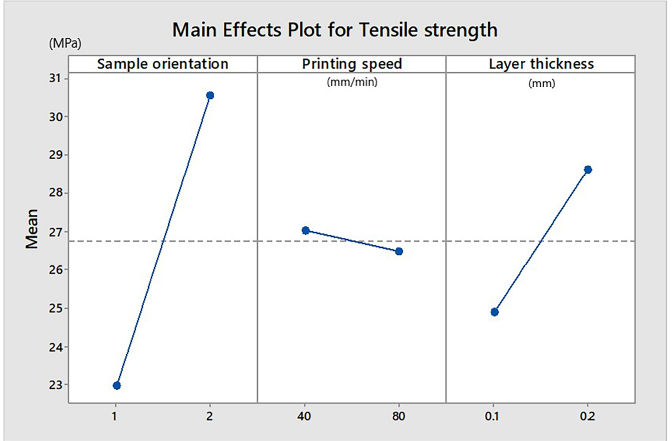
Figure 2. Influence of parameters on tensile strength (Extrudr BDP Flax samples). Sample orientation: 1—plan and 2—on edge.